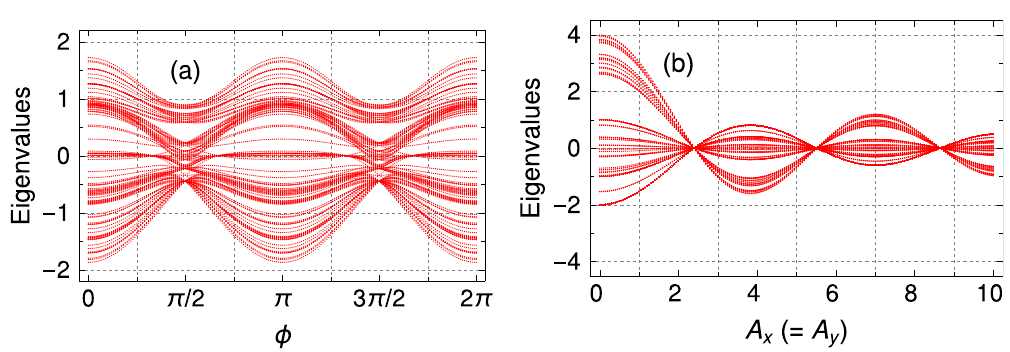
2 and φ π/ 2 , ( c ) A x A y = = =